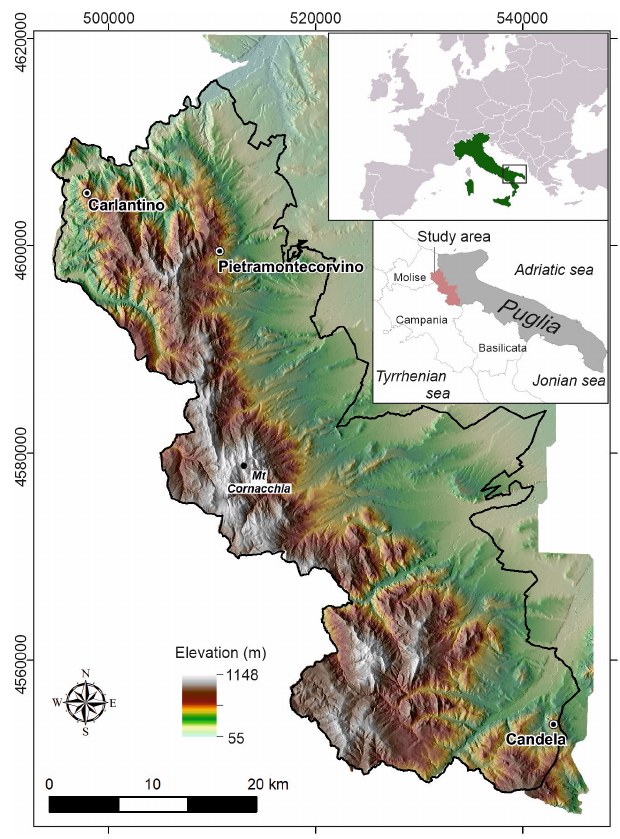
Figure 1. Location map of the study area. Base map: digital ter- rain model (DTM) at 8m resolution made available by the Regione Puglia